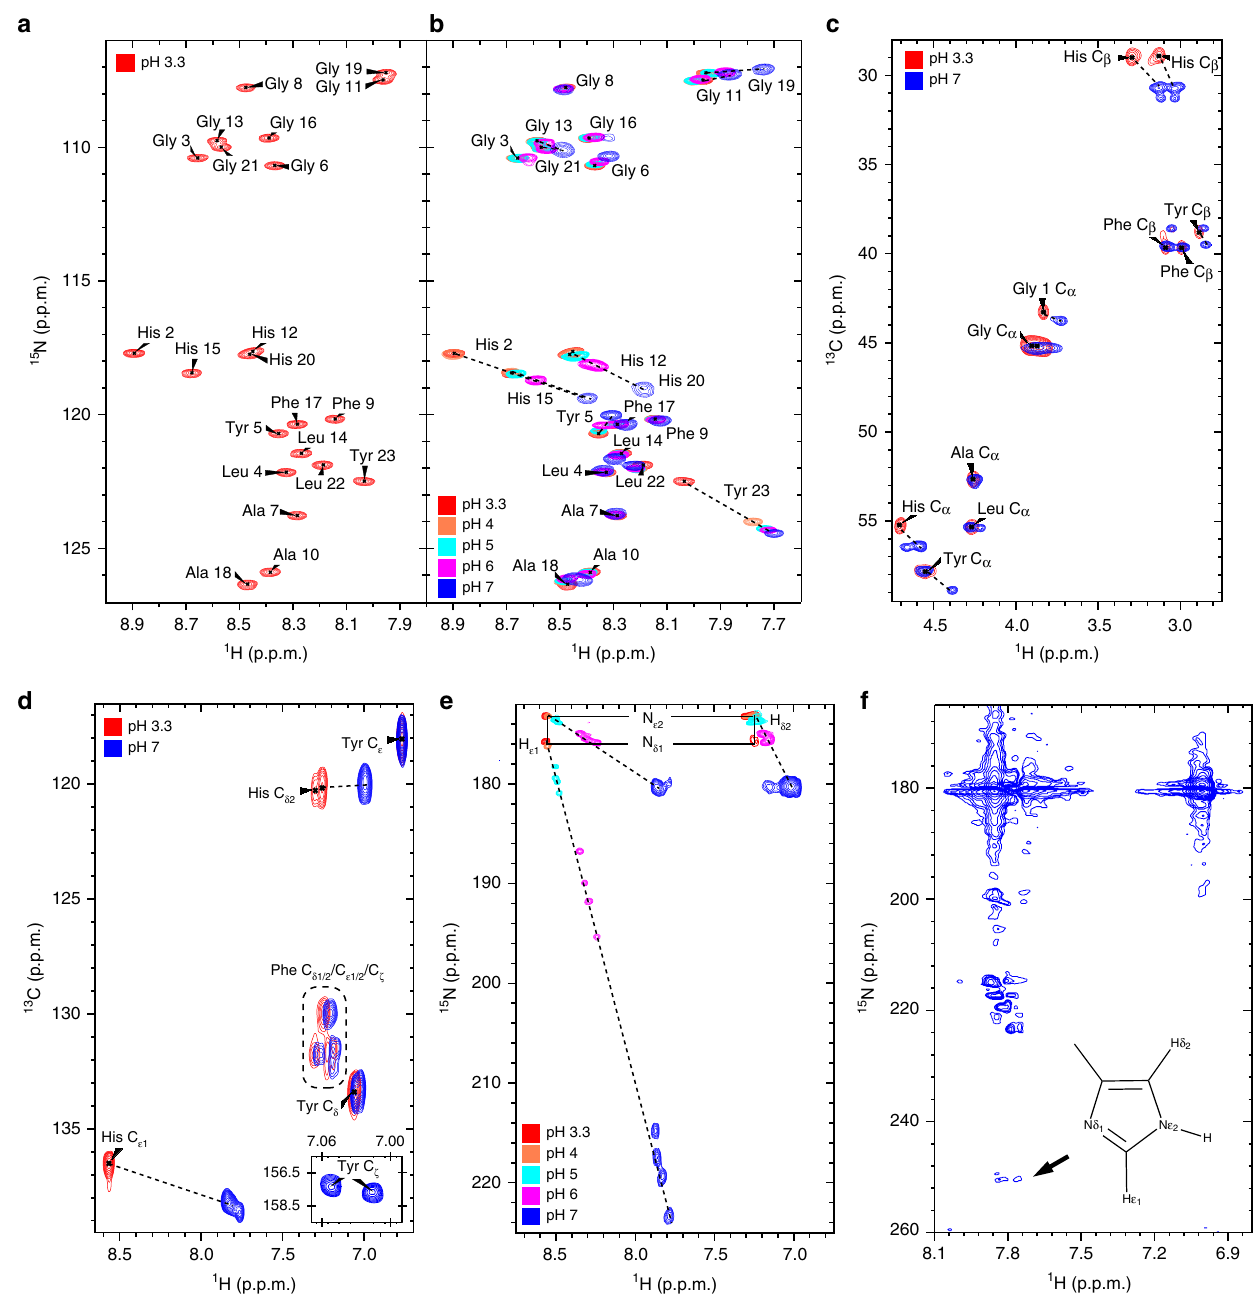
Fig. 4 NMR spectra of GY-23 peptide at different pH values (cross-peak trajectories marked with dashed lines). a 1 H- 15 N-HMQC spectrum at initial conditions of pH 3.3. b Overlay of 1 H- 15 N-HMQC spectra acquired between pH 3.3 and 7 (pH 7: initiation of LLPS). c , d Overlay of 1 H- 13 C-HSQC spectra of aliphatic ( c ) and aromatic ( d ) side chains at pH 3.3 and 7. The inset shows Tyr 1 H δ - 13 C ζ cross-peaks at pH 7. e Overlay of long-range 1 H- 15 N-HMQC spectra of His side chains. The resonance assignments in the protonated state (pH 3.3) are indicated. f Long-range 1 H- 15 N-HMQC spectrum at pH 7 acquired within 5 min after pH adjustment showing transient stabilization of His ε -tautomer with characteristic resonance at ca. 250 ppm marked with the arrow. In the spectrum acquired after 30 min of pH adjustment, this cross-peak was signi fi cantly attenuated (Supplementary Fig. 11). Spectra acquired at 298 K and peptide concentration of 1.5 mM. The trajectories (chemical shift values vs. pH) of 13 C atoms of Tyr as well as 13 C and 15 N of His are provided in Supplementary Fig.